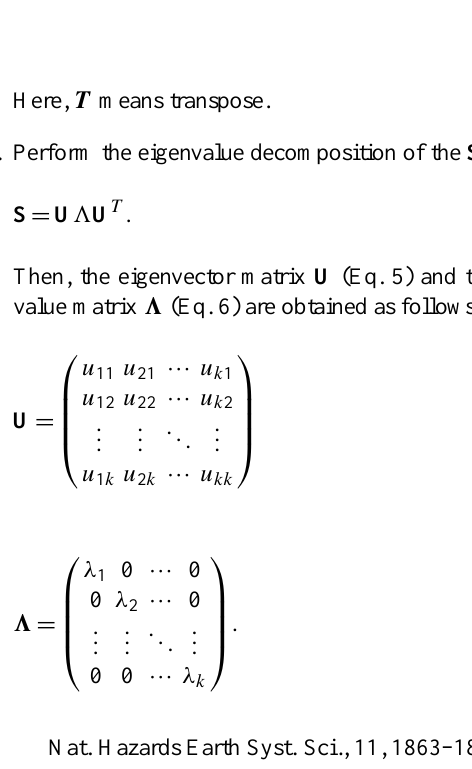
Fig. 4. An example of SSA. A variation of the monthly average of air temperature at Chiba from January 1967 to December 2007 has been investigated. (a) The monthly average of air temperature and its trend, (b) the reconstructed annual component, (c) the reconstructed seasonal component (4-month period), (d) the reconstructed components of a six-month period, and (e) the noise component reconstructed from the residuals.